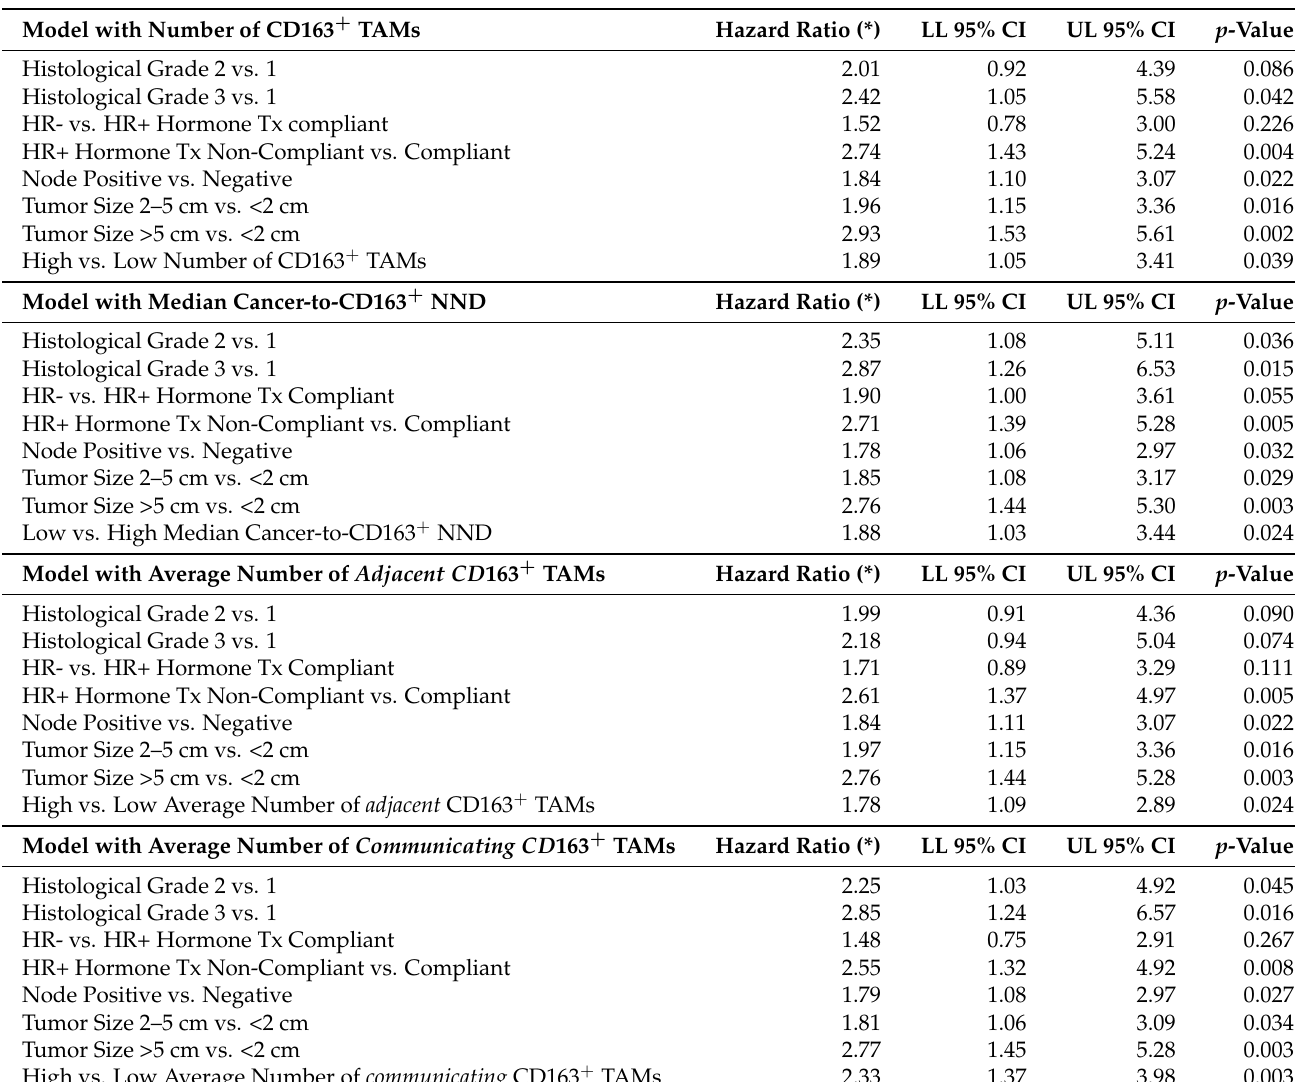
Table 3. Bias-adjusted results from the parsimonious Cox models with significant CD163